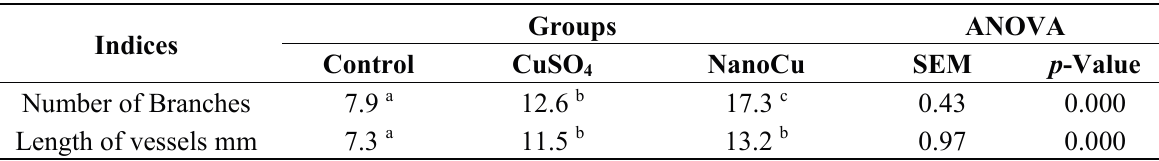
Table 2. The number of branches of blood vessels examined on implants (with diameter 1 cm) incubated on the chick embryo chorioallantoic membrane, after in ovo treatment with CuSO 4 and nanoparticles of Cu (NanoCu).